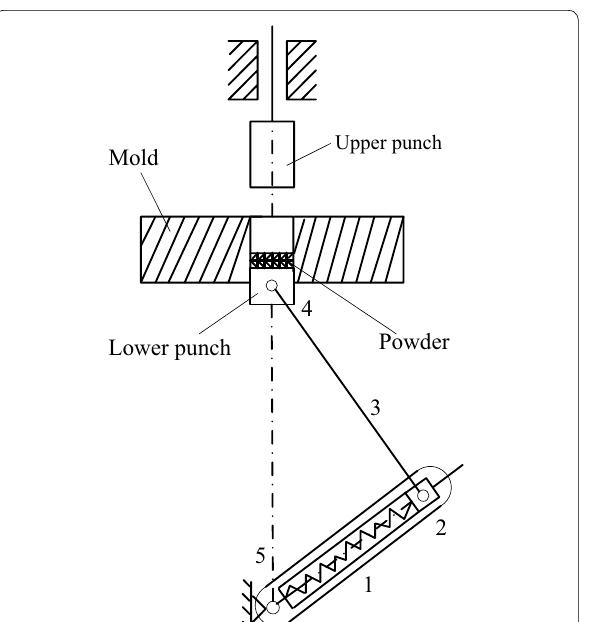
Figure 11 Structural sketch map of tablet press machine